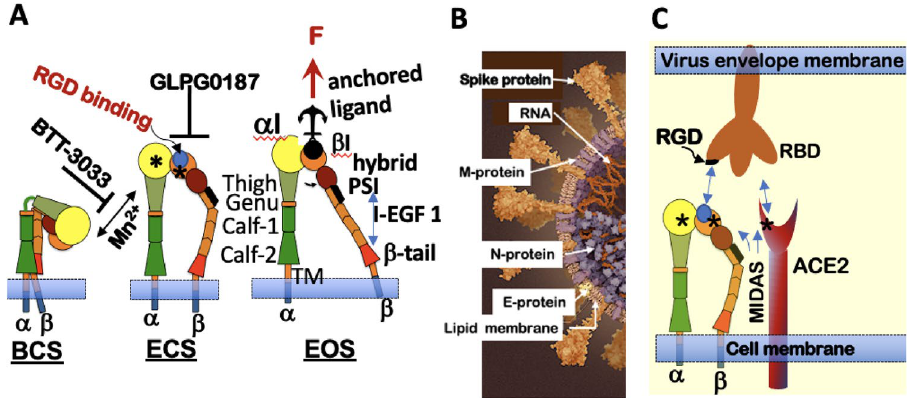
Figure 1. Integrin conformational states antagonist targets and SARS-CoV-2 binding. ( A ) Integrin States: First, the inactive, bent-closed state (BCS), with a closed headpiece and low affinity for extracellular matrix (ECM) ligands. The bent structure inhibits the receptors from inappropriate signaling due to random binding to extracellular matrix proteins. In the BCS form, binding to large ligands is likely limited. Second, when primed, integrins exhibit an extended-closed state (ECS) with a closed headpiece and higher ligand binding affinity than BCS. Third, active and extended-open state (EOS) with an open headpiece and maximum affinity for ECM ligands. Integrin Affinity Regulation: Mn 2+ binding to the MIDAS site at the αI and βI domain integrin induces integrin extension. α 2 β 1 integrin antagonist BTT 3033 binds to the α-I domain, and stabilizes the BCS. GLP0187 blocks binding to the RGD ligand-binding domain. EOS binding to a macromolecular ligand or ECM generates a force (F) transmitted through the integrin β subunit. ( B ) Model of Sars-CoV-2 virion structure (https:// www. scien tific ameri can. com/ inter active/ inside- the- coron avirus/). SARS-CoV-2 are spherical or ovoid particles of sizes that span the range of 60–140 nm. The SARS-CoV-2 virion consists of a lipid bilayer envelope membrane covering a large nucleoprotein (N)-encapsidated, positive-sense RNA genome. The lipid envelope is decorated with three transmembrane proteins consisting of trimeric spike proteins (S) that project above the lipid bilayer membrane and relatively small membrane (M) and envelope (E) proteins 78,79 . S proteins bind with high- affinity (1–50 nM) 4 to the angiotensin-converting enzyme 2 (ACE2) for productive infection 80 . ( C ) Cartoon alignment of the receptor-binding domain (RBD) and RGD sequence on the trimeric spike protein, which favors engagement of activated integrin, adapted from ref. 25 The illustrations were generated using Microsoft ® PowerPoint Version 16.51